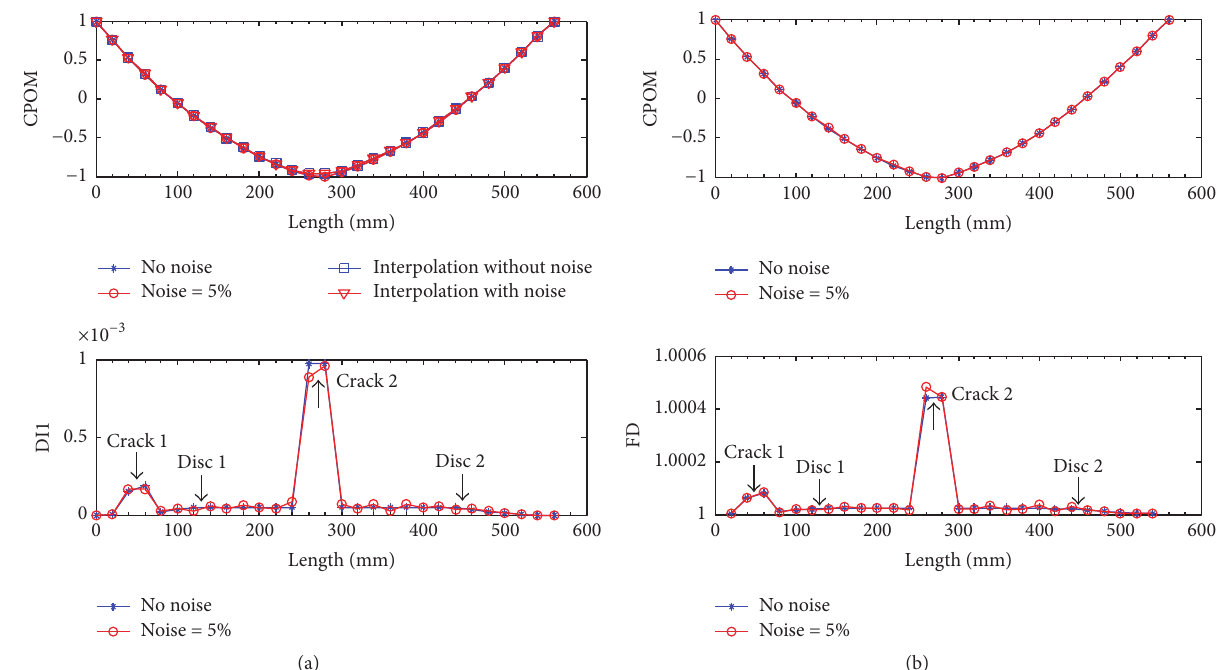
Figure 13: Localization results of double-cracked rotor in case 6. (a) Localization using GSM by linear gapped interpolation. (b) Localization using FD.